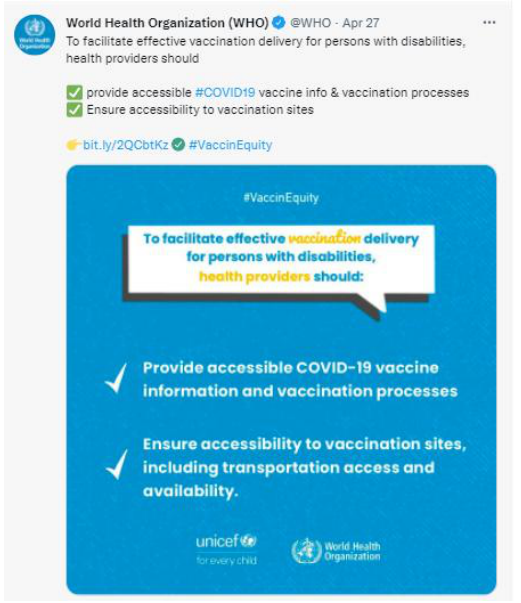
Image 2: A Tweet from WHO Representing the Vaccination Guidelines (Source: WHO